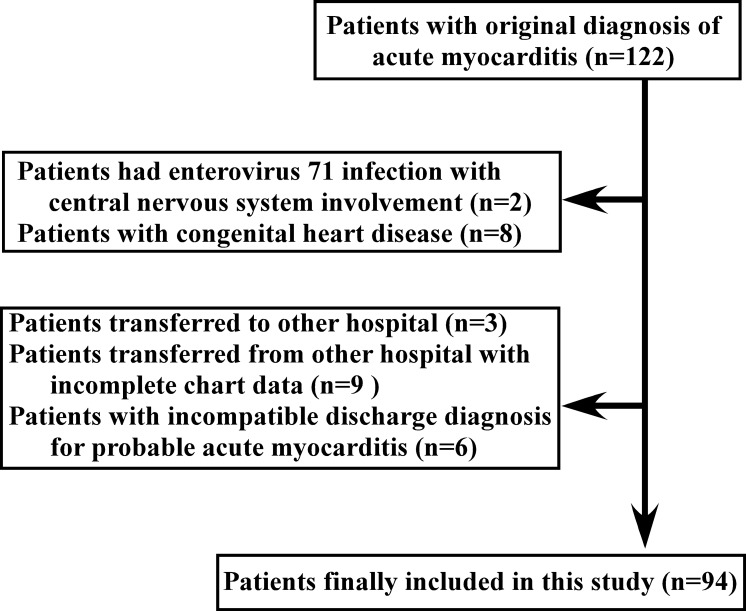
Flow diagram for selection of myocarditis cases.